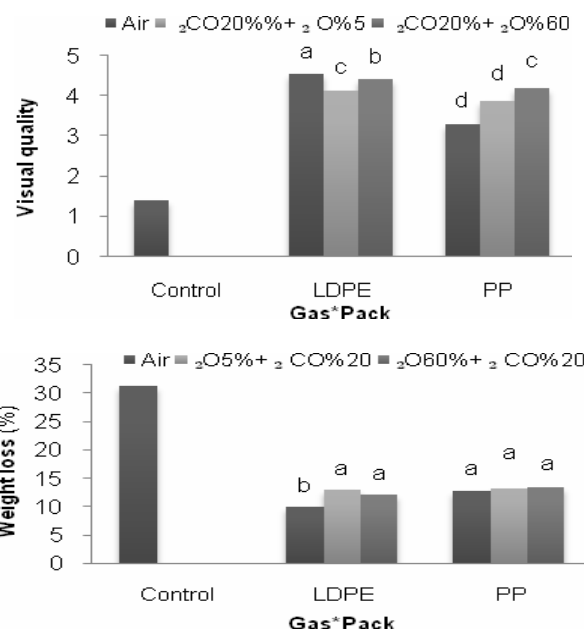
Fig. 1. Changes in visual quality and weight loss of cornelian cherry fruits after 35 days of storage at 1 under three gas combinations: 5%O +20%CO +75%N , 60O +20CO + 20%N and Air in two 2 2 2 2 2 2 types of polymeric films: LDPE- low density polyethylene, PP- polypropylene compared with control